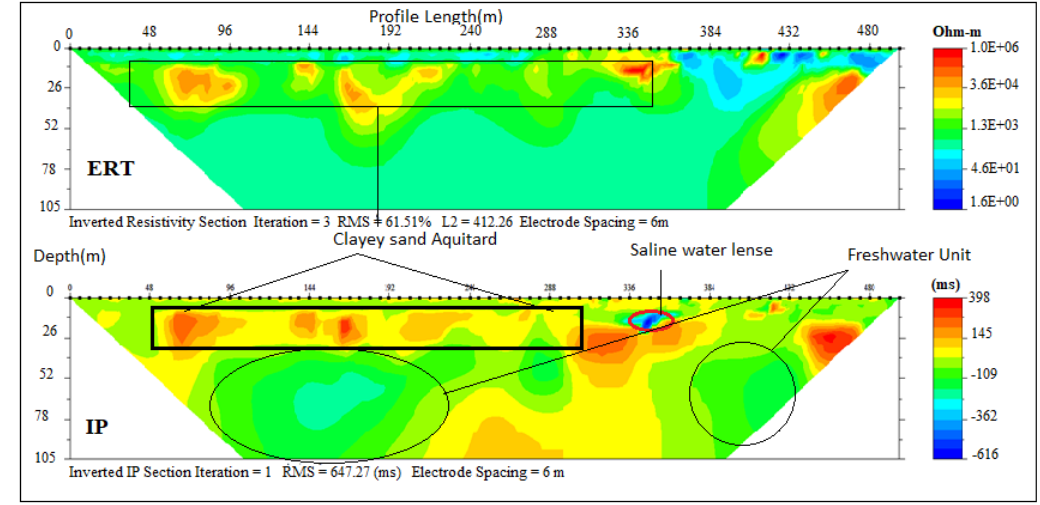
Figure 7. Inverted resistivity and IP cross-sections of Okitipupa road (Profile section P4).